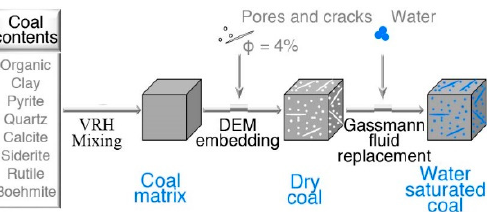
Figure 4. Schematic flowchart for rock-physics modeling of mineral-rich cores.